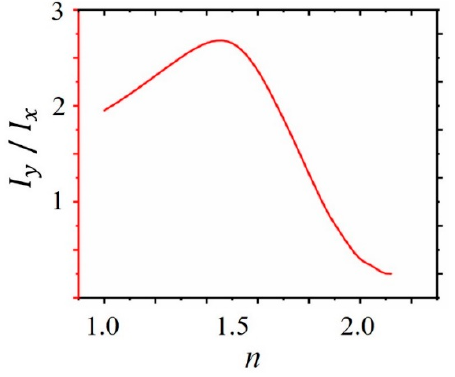
Figure 6. Dependence of the splitting ratio on the refractive index of the dielectric in the gap for h = 150 μ m.